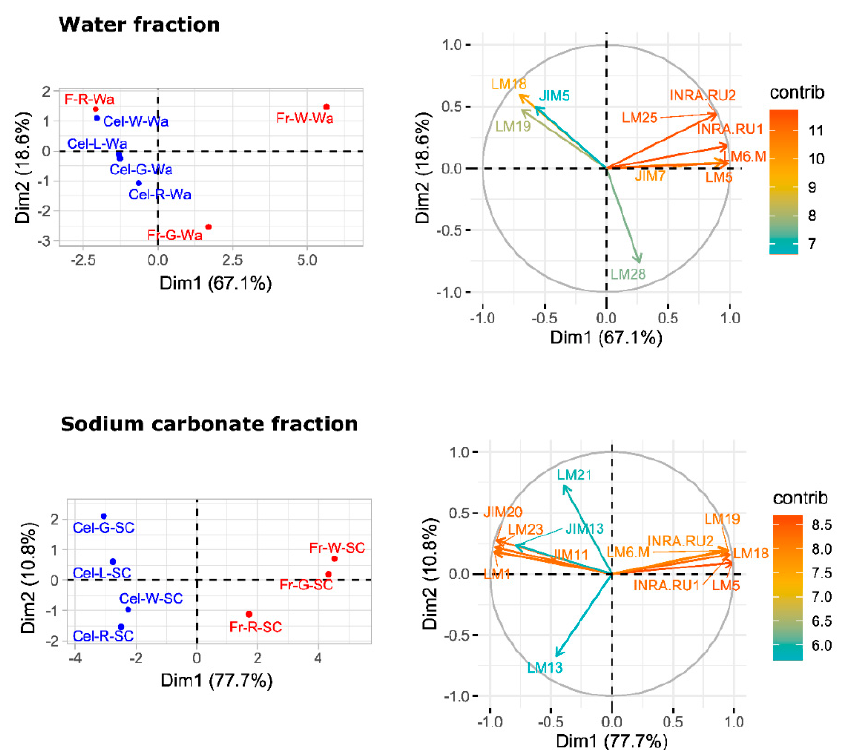
Figure 7. PCA analysis of carbohydrate microarray data from pectin enriched fractions, water, and sodium carbonate fractions. The factor score plots are shown in the left and the variable plots in the right . The color scale in the variable plots represents the average contribution of the variable to the variation explained by the two principal components. Fr: fruit; Cel: callus culture; G: green stage; W: white stage; R: red stage; Wa: water fraction; SC: sodium carbonate